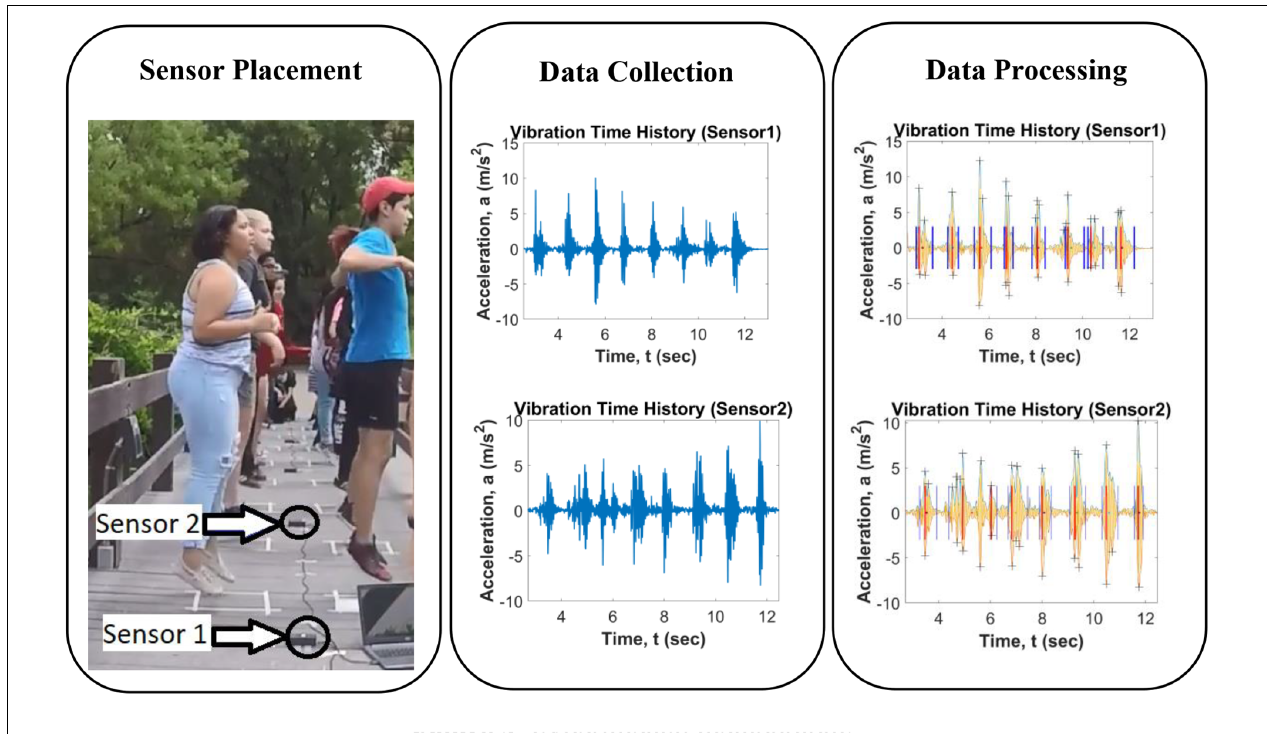
FIGURE 4 | Experimental